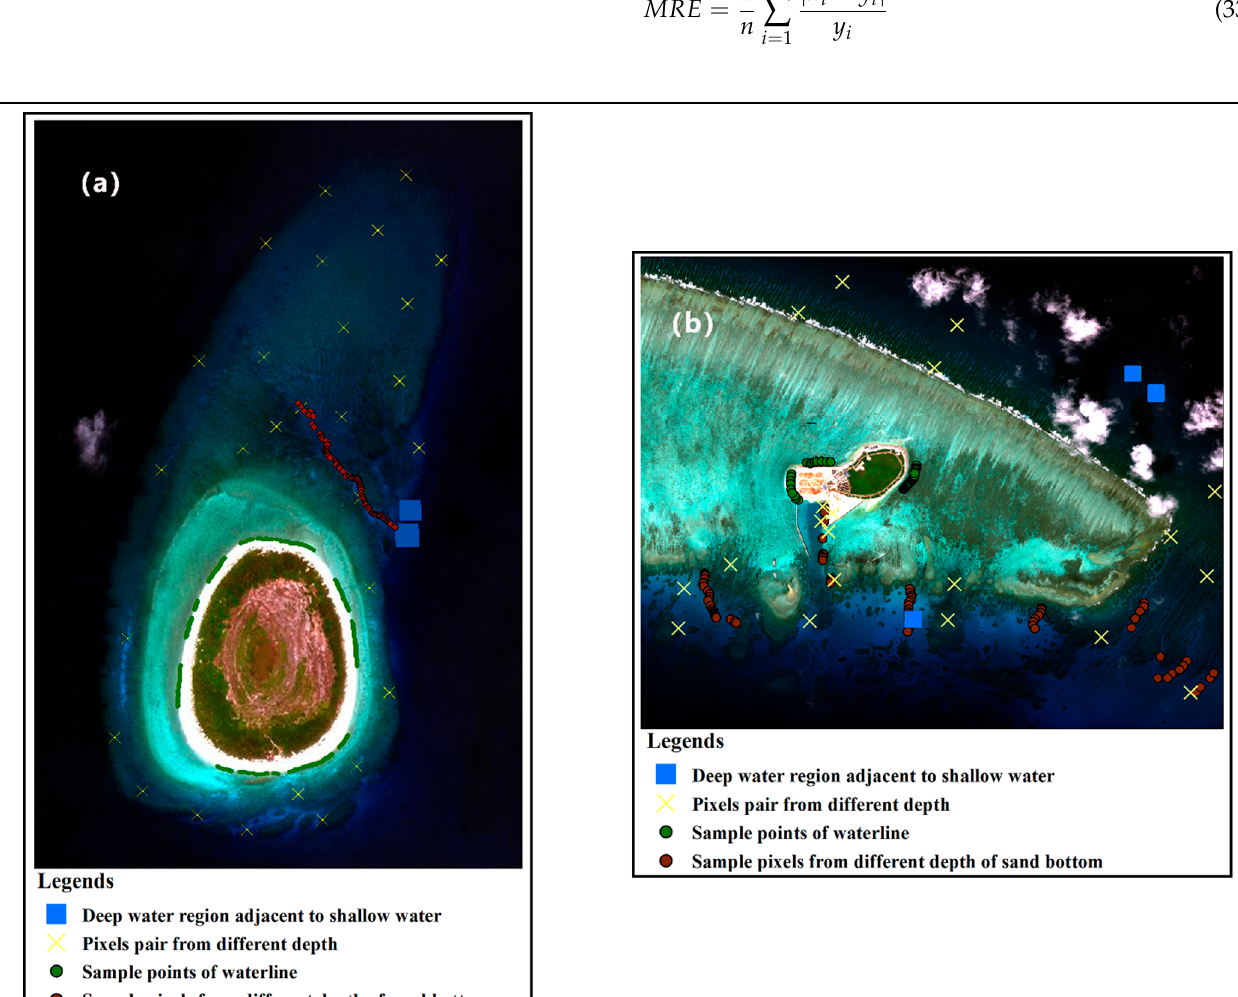
Figure 5. Distribution of the sampling points in ( a ) Ganquan Island and ( b ) Zhaoshu Island.